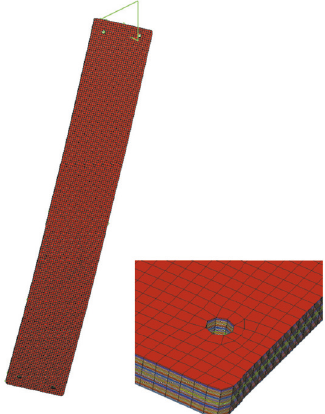
Figure 5: The leaf spring component: the finite element model, with a detailed